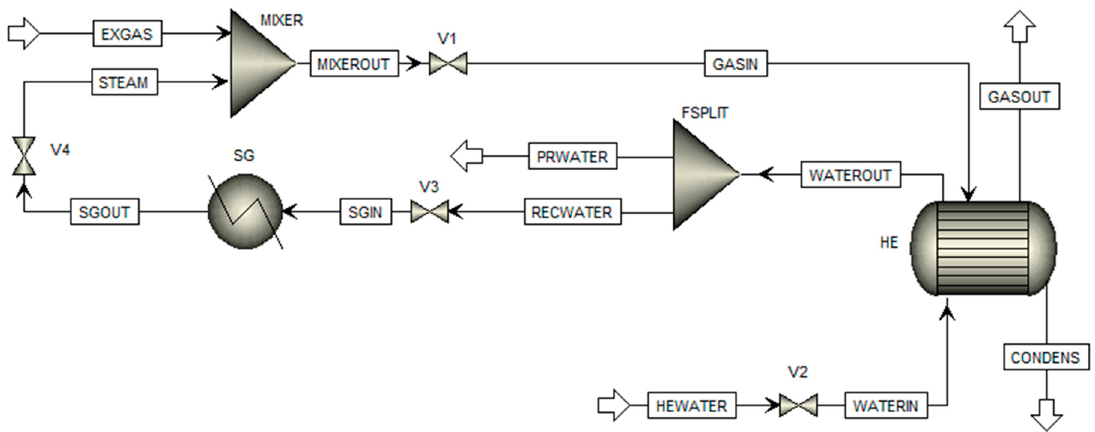
Figure 2. Flowsheet for the humidification of the flue gas using